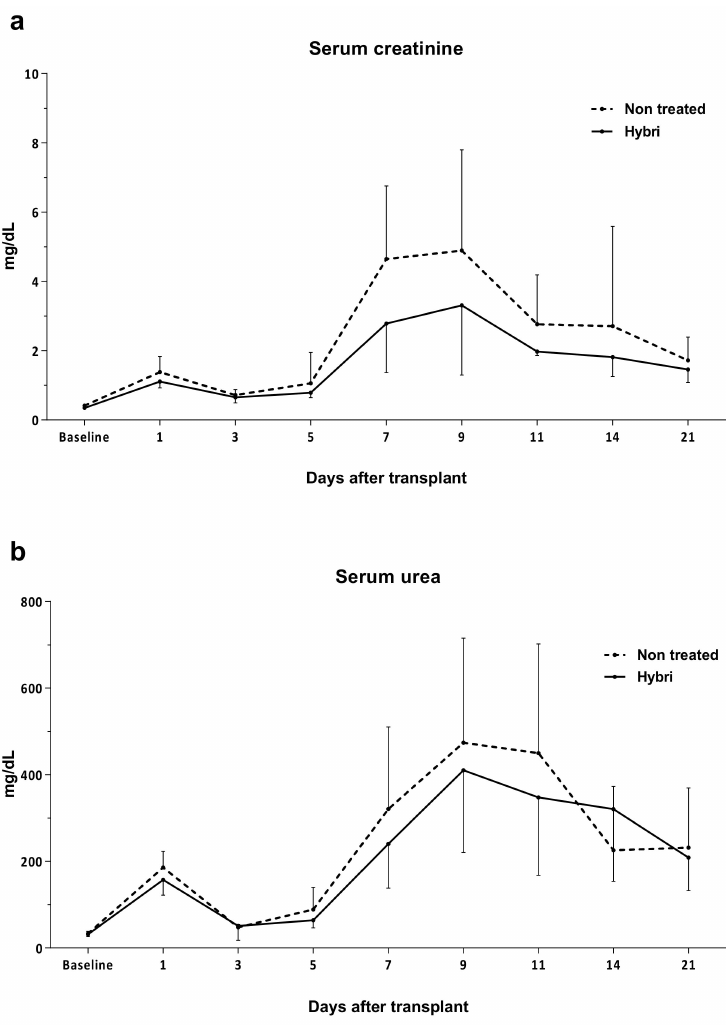
Figure 6. Functional renal parameters throughout the allogeneic transplant model for HYBRI treat- ment and non-treated groups. ( a ) Serum creatinine and ( b ) serum urea levels for the initial 21 days of the study. Values are expressed in mg/dL. Data are expressed as